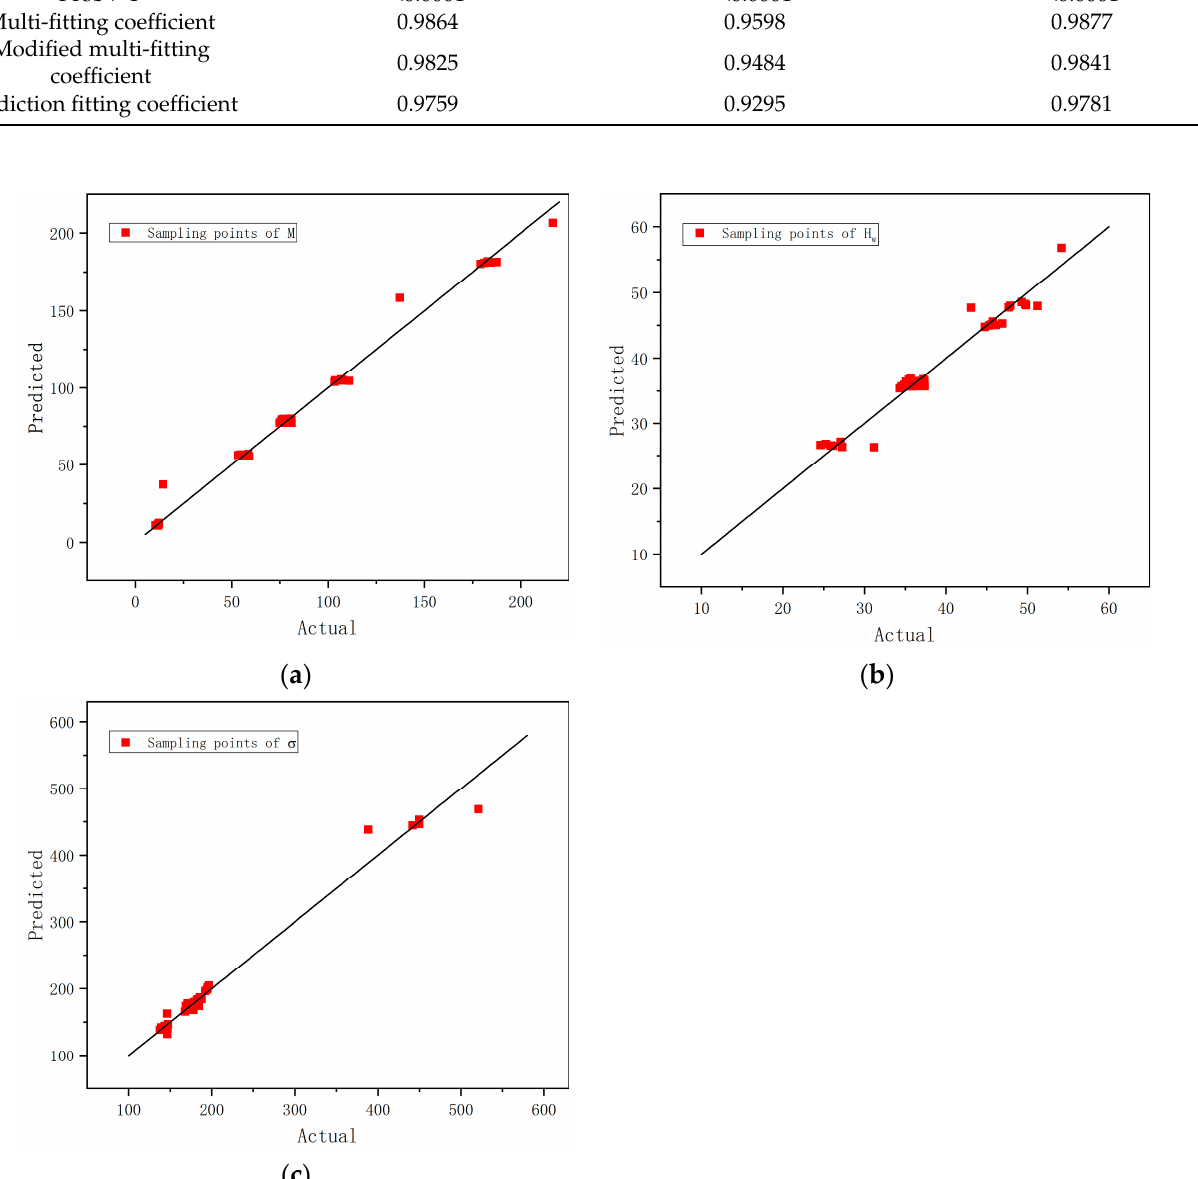
Figure 2. Comparison of predicted and true values. ( a ) The ( 𝑋 , 𝑌 ) scatter data points of average torque acting on drum; ( b ) the ( 𝑋 , 𝑌 ) scatter data points of specific energy; ( c ) the ( 𝑋 , 𝑌 ) scatter data points of average stress acting on pick.